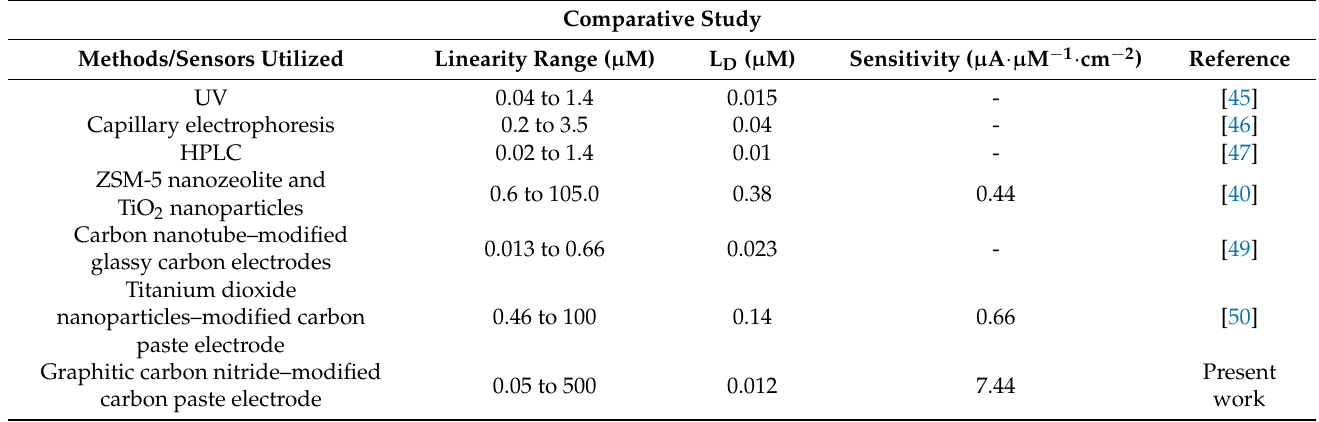
Table 1. Comparative statement with pre-reported